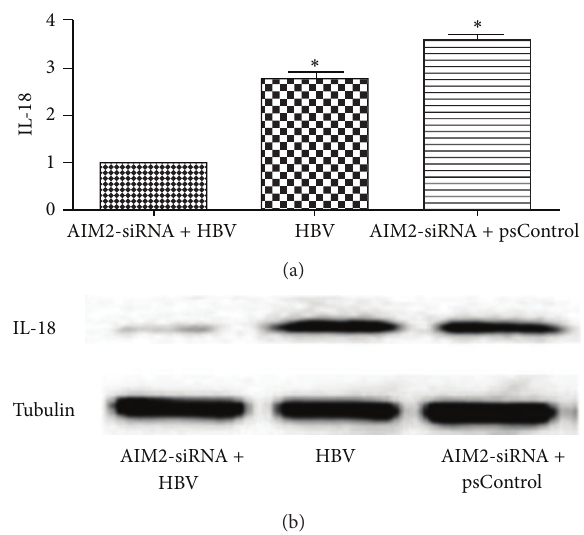
Figure 5: Down-regulation of AIM2 reduced expression of IL-18 at the post-transcriptional level (a) and at the translational level (b). HGM cells were divided into three groups: AIM2-siRNA and HBV DNA co-transfected group (group A), HBV DNA-transfected group without AIM2-siRNA(group B) and AIM2-siRNA and empty plasmids co-transfected group (group C). The expression of IL-18 in group A detected by qRT-PCR decreased in 1.8, 2.7 folds respectively compared with group B and group C (a). These changes were also noted at the translational level, as measured by Western blot (b). ∗ indicates a significant difference compared with the control ( 𝑃 < 0.01 ). 𝑛 = 3 independent experiment RNA samples for each